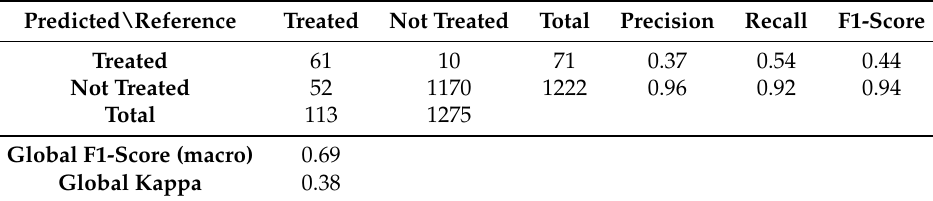
Table 4. Confusion Matrix for the RF algorithm using the Sentinel-1 data (ASC and DESC). Predicted\Reference